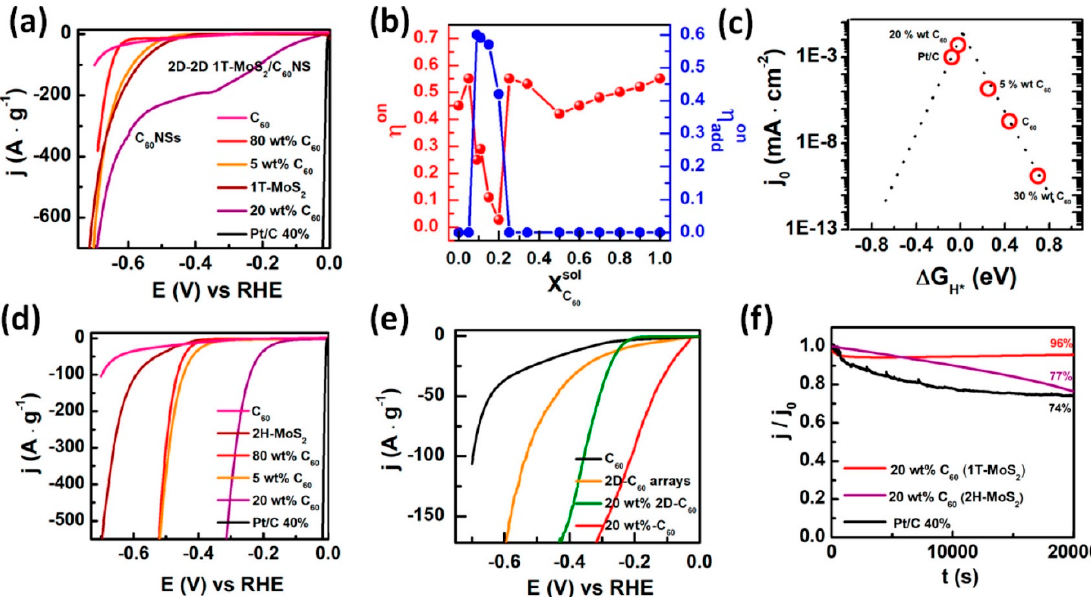
Figure 7. ( a ) Mass-standardized current density for C 60 , 1T-MoS 2 , commercial Pt/C 40%, and the 1T-MoS 2 /C 60 heterostruc- tures with 5, 20, and 80 wt.% of C 60 in 0.5 M H 2 SO 4 . ( b ) HER onset overpotential values as a function of the C 60 volume fraction in solution. ( c ) Volcano plots of the as-synthesized vdW 1T-MoS 2 /C 60 . ( d ) Mass-standardized catalytic currents for C 60 , 2H-MoS 2 , commercial Pt/C 40%, and the 2H-MoS 2 /C 60 heterostructures with 5, 20, and 80 wt.% of in 0.5 M H 2 SO 4 . ( e ) Mass-standardized LSVs for C 60 , C 60 NSs, 20 wt.% 2D-C 60 , and 20 wt.% C 60 in 0.5 M H 2 SO 4 . ( f ) Chronoamperometric curves of 2H-MoS 2 /20 wt.% C 60 and 1T-MoS 2 /20 wt.% C 60 at − 0.35 V vs. RHE. Reprinted from [49], Copyright (2020) with permis- sion from American Chemical Society.